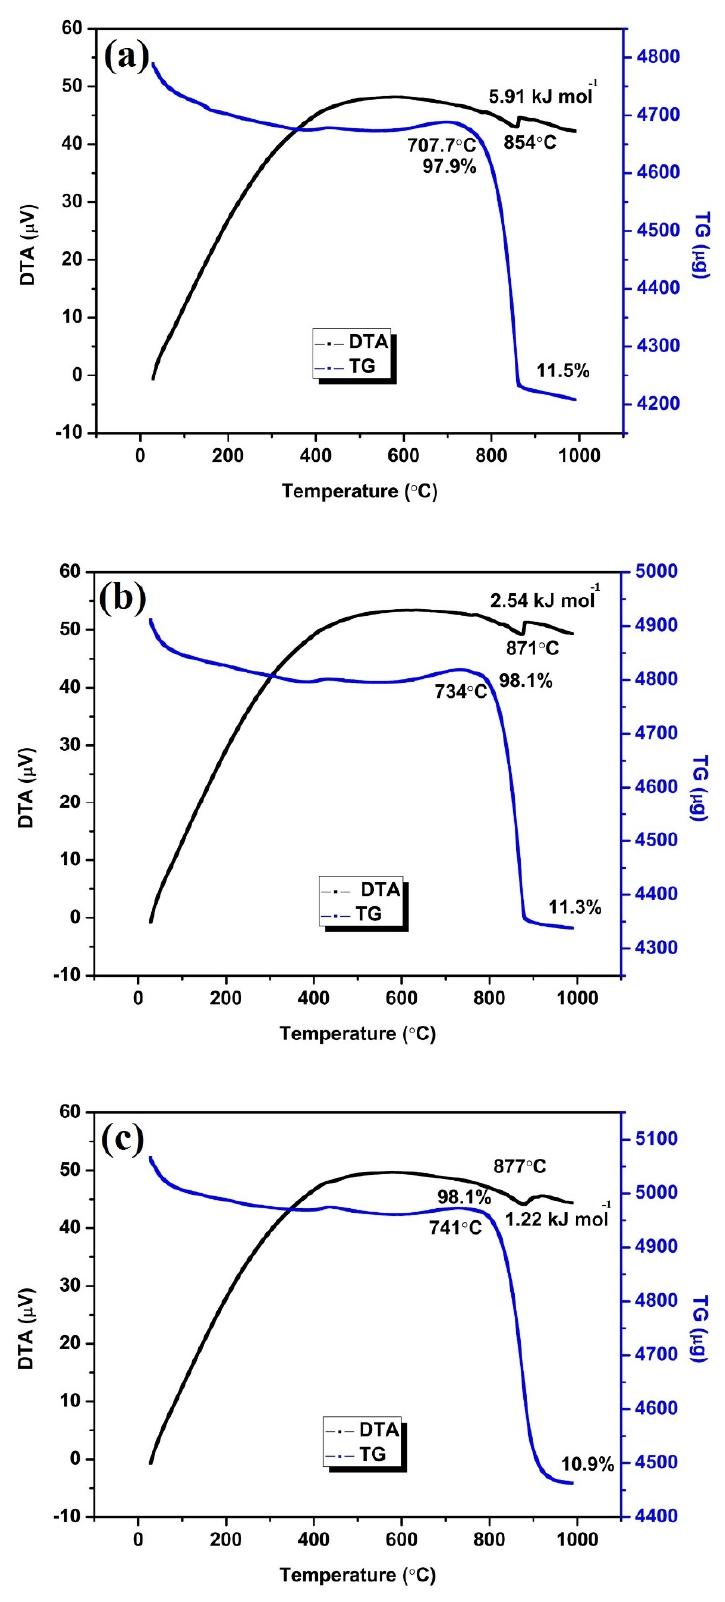
Figure 7. Thermogravimetric and differential thermal analysis curve of biosynthesized CuO NPs at